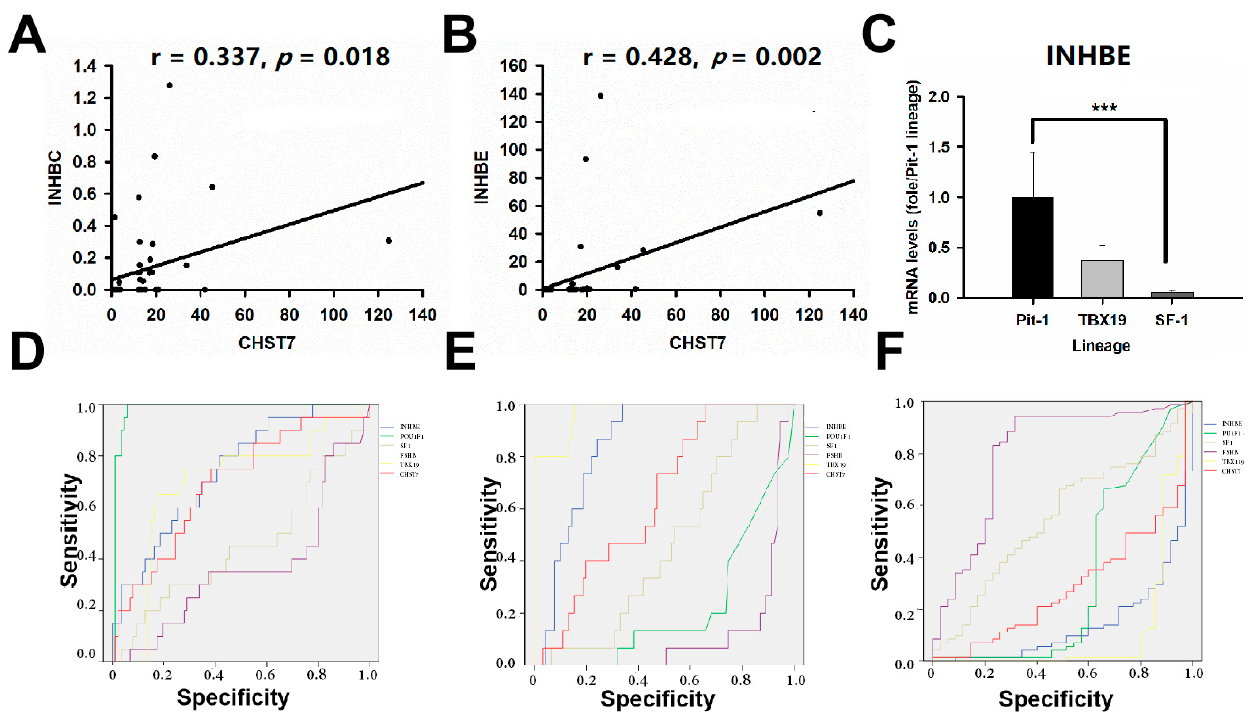
Figure 7. INHBE is related to the tumor differentiation of PAs. ( A ) The correlation analysis of CHST7 and INHBC. ( B ) The correlation analysis of CHST7 and INHBE. ( C ) mRNA levels of INHBE in the three lineages. *** p < 0.001. ( D ) ROC curve of INHBE for the Pit-1 lineage. ( E ) ROC curve of INHBE for the TBX19 lineage. ( F ) ROC curve of INHBE for the SF-1 lineage.